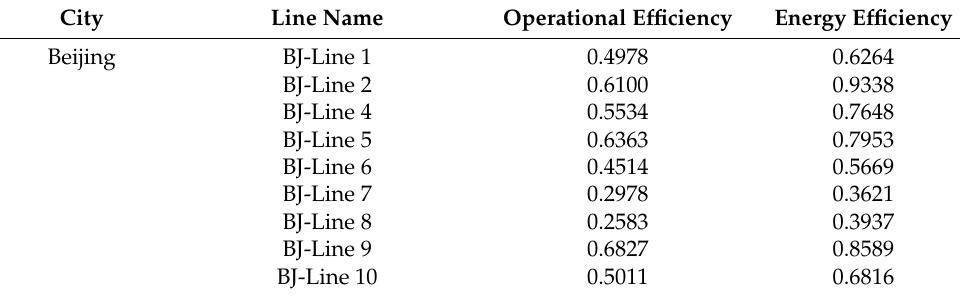
Table 2. The efficiency of the URT systems in case